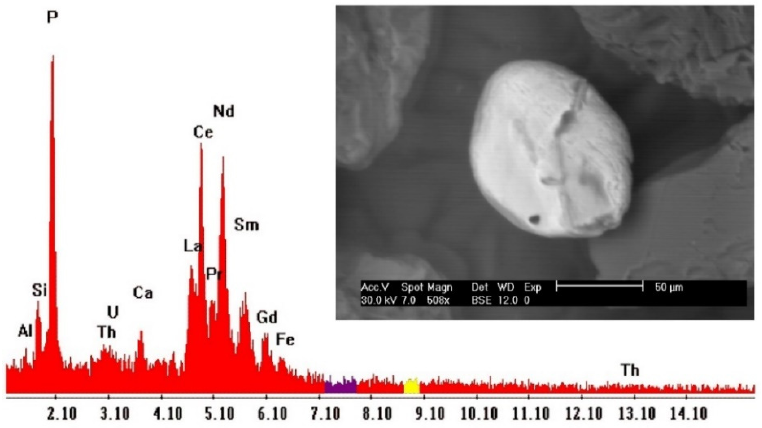
Figure 4. SEM/EDX of monazite (sample 1).